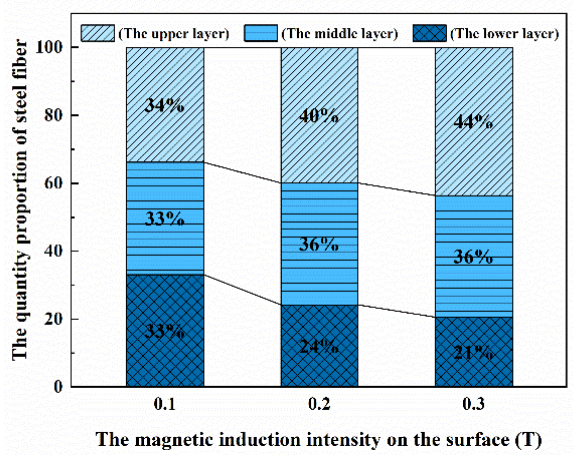
Figure 10. The quantity proportion of the steel fiber in different areas with a distance of 0 mm.